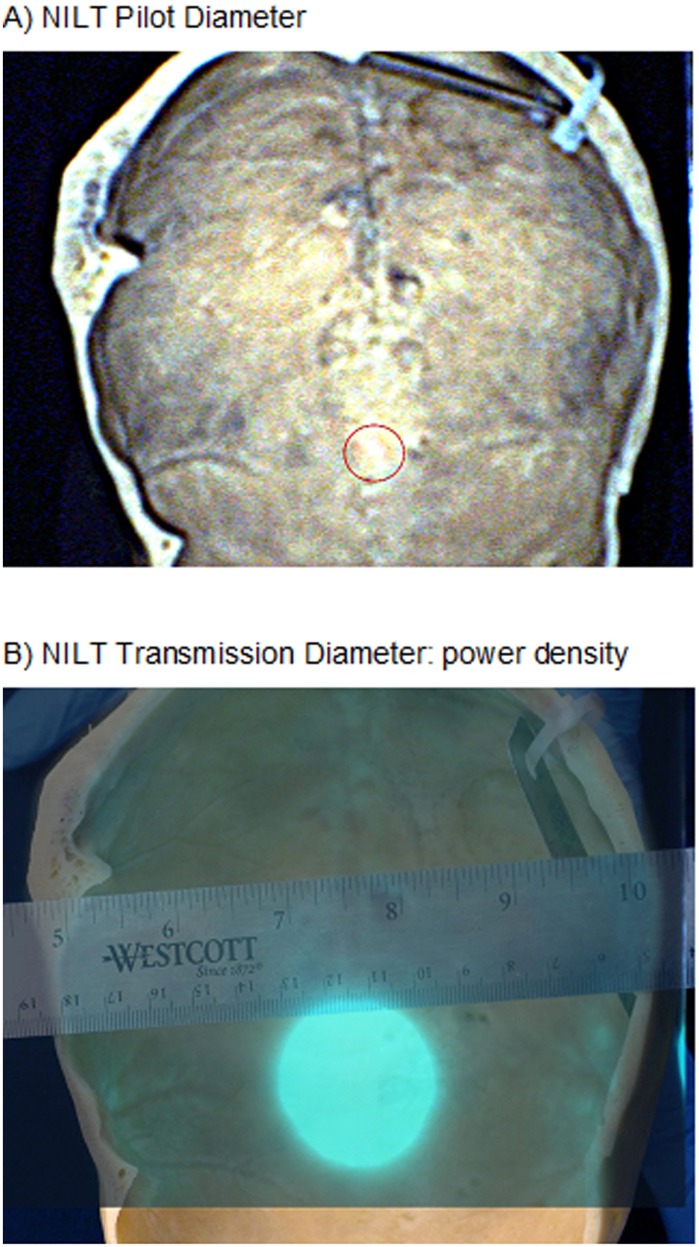
Dehydrated Human Calvaria #12–325 NILT Penetration.Ventral surface of the human skull showing NILT transmission (A) and the limited diffusion pattern observed (B).